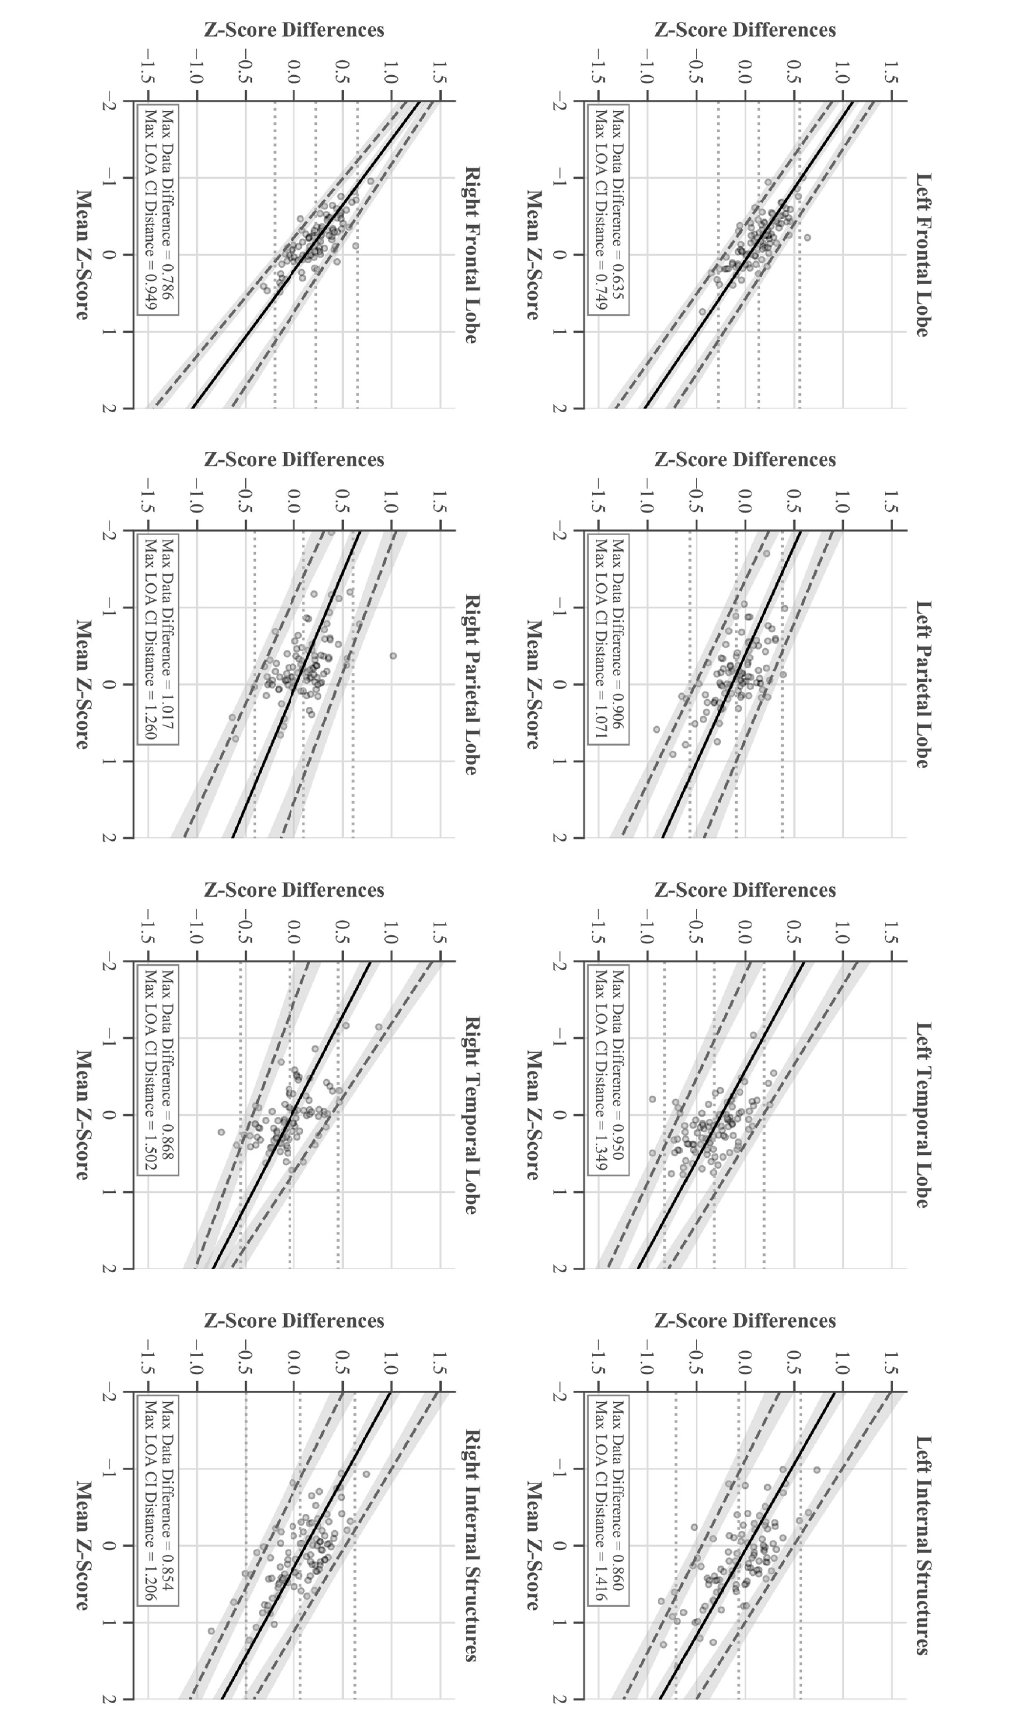
Figure 8. Bland-Altman plots with linear LOAs and CIs for each region accounting for proportional bias present in the data. Original mean and horizontal LOAs are represented by light gray dashed